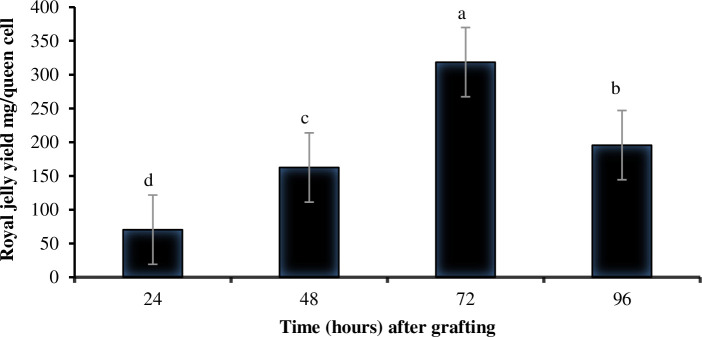
Effect of harvesting time on royal jelly yield (mg/queen cell).